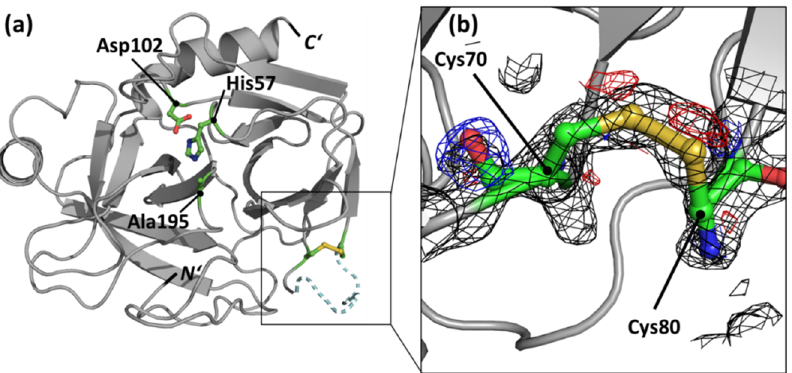
Figure 3. Crystal structure of aTn(bov) S195A. ( a ) The whole structure is shown as cartoon. For better orientation, the catalytic center consisting of His57, Asp102, and Ala195 are marked in the green sticks. The unresolved residues 73 to 79 are shown as dashed lines. ( b ) Depicted is the introduced disulfide bridge. Both cysteine residues are shown as green sticks. In addition, the electron density (FoFc and the 2FoFc) maps are indicated as black mesh (pdb-ID 8ADT).